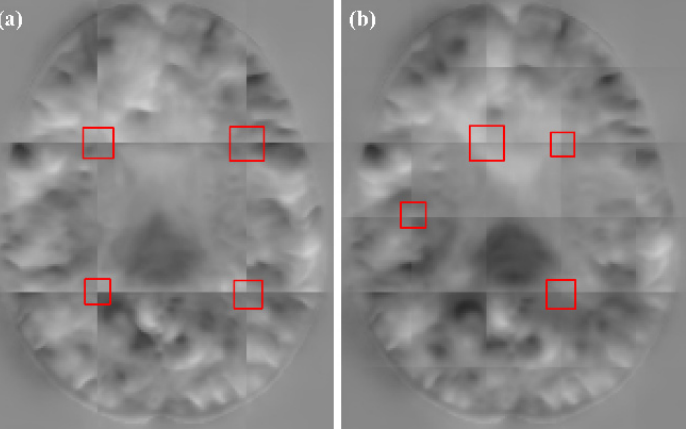
Figure 3. DDF obtained by fusion ( a ) without patch overlapping and ( b ) patch overlapping.